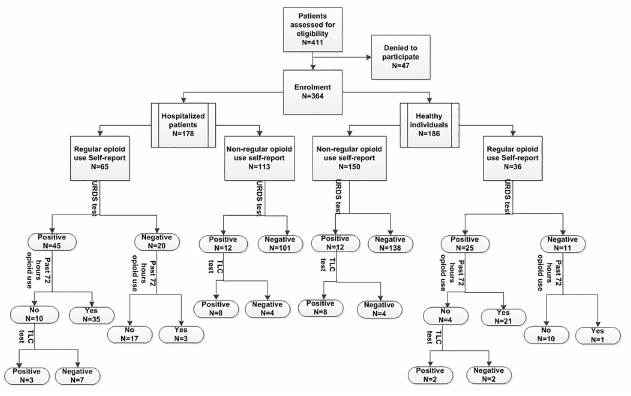
Fig 1. Flowchart of study participation, self-reported opioid use and urine test results in healthy individuals and hospitalized patients.